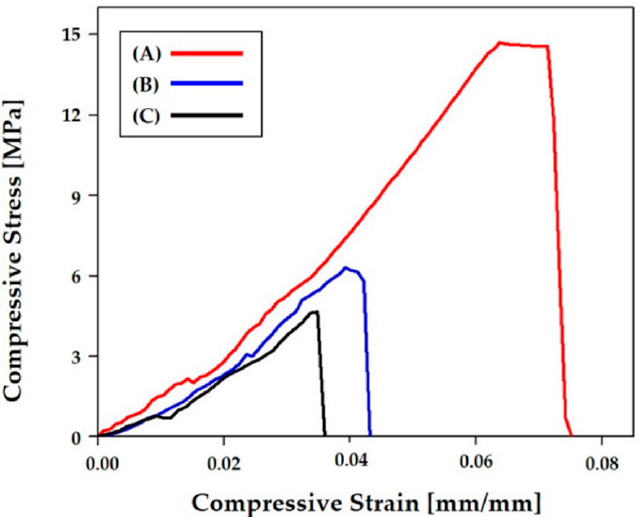
Figure 12. Representative compressive stress versus strain responses of porous CaP scaffolds with different pore orientations of ( A ) 0°/90°, ( B ) 0°/45°/90°/135°, and ( C ) 0°/30°/60°/90°/120°/150°.